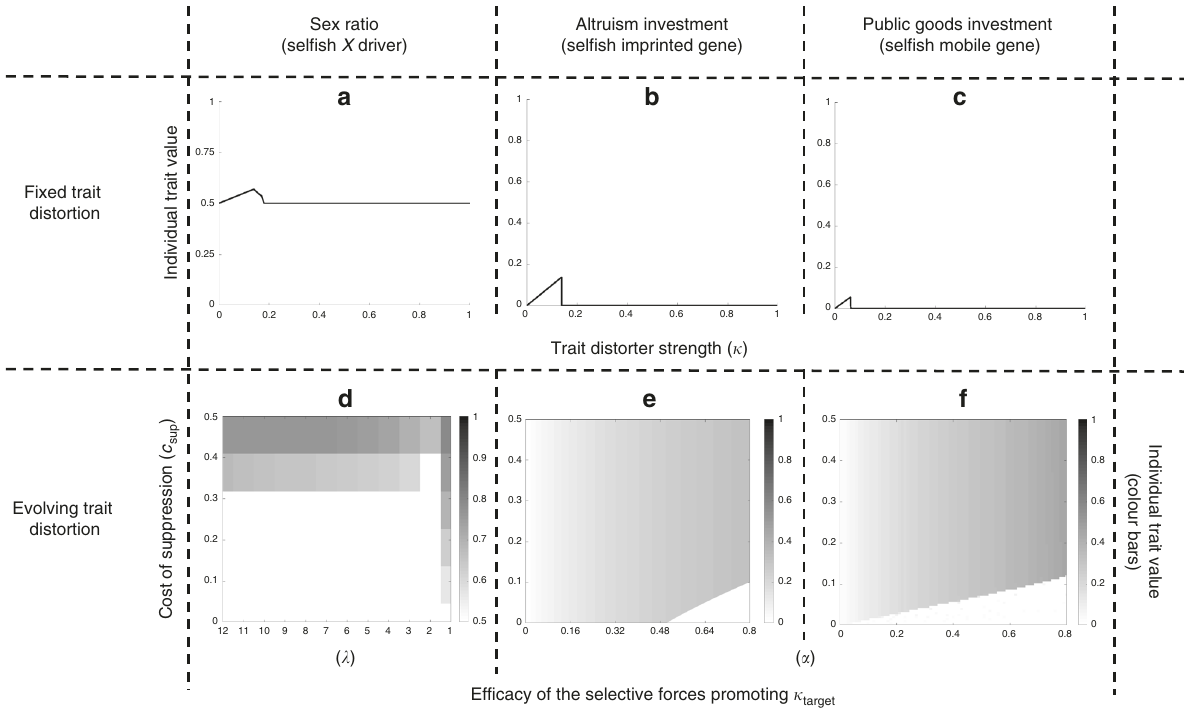
Fig. 3 Speci fi c biological scenarios. We consider three biological scenarios: a , d sex ratio distortion by an X driver; b , e cooperative investment by an imprinted gene (cost and bene fi t of cooperation are c = k and b = k α , respectively); c , f cooperative public goods investment by a mobile gene (cost and bene fi t of cooperation are c = k and b = 8 k α , respectively). In all three scenarios, we obtain the same pattern as our illustrative model, that trait distorters have either a minor impact at the individual level or are suppressed ( c sup = 0.05; a : λ = 2; b , c : α = 0.9). In d – f , we allowed the trait distorters to evolve. We show how the equilibrium level of distortion is determined by the cost of suppression ( c sup ), and parameters that determine the target level of trait distortion ( k target ; d : λ ; e , f : α ). Trait distortion is low unless there is both a high cost of suppression ( c sup ) and a high target level of trait distortion (top right of heat